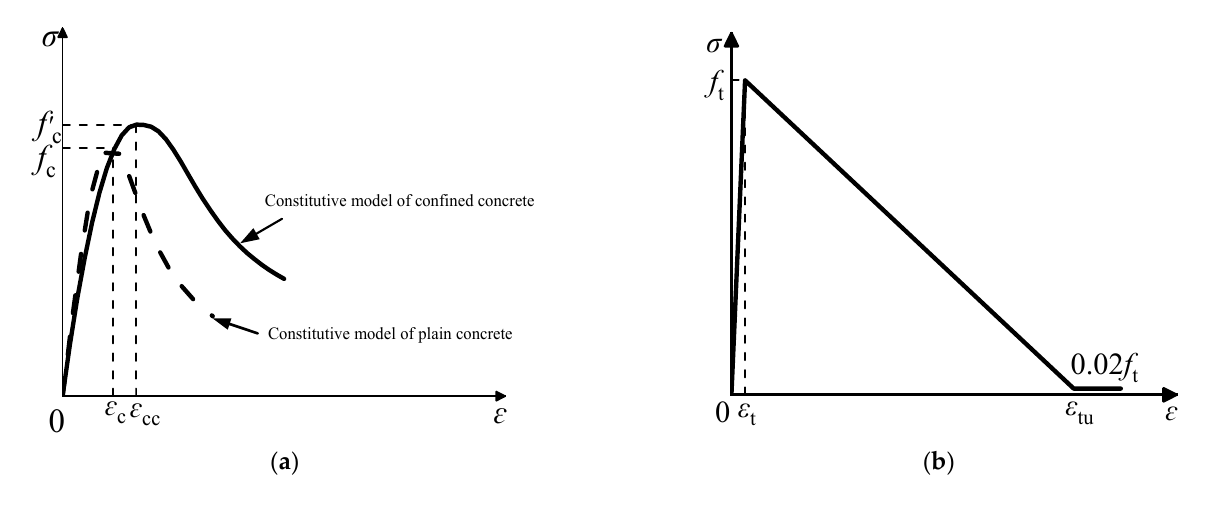
Figure 4. Stress-strain curves of concrete. ( a ) Compressive stress-strain relationship of concrete. ( b ) Tensile stress-strain relationship of concrete.